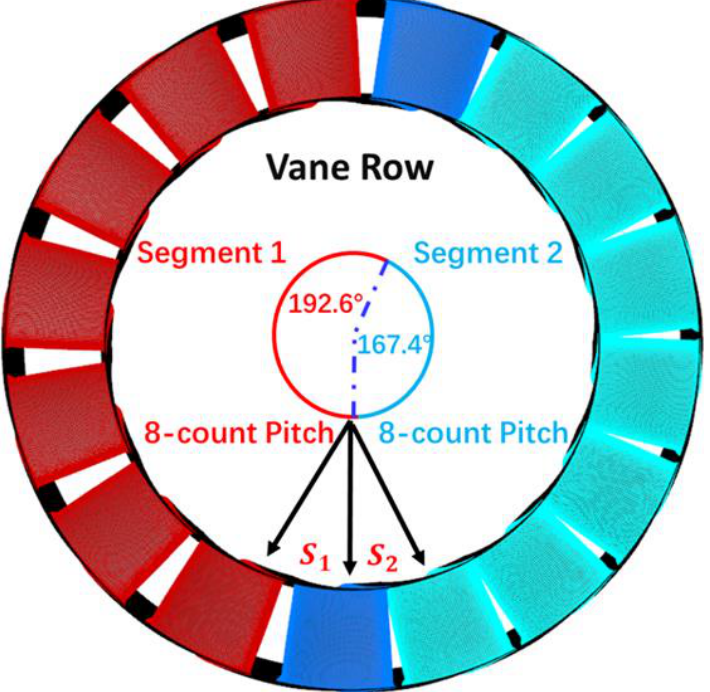
Figure 17. Schematic of Non-half Two-segment Layout.